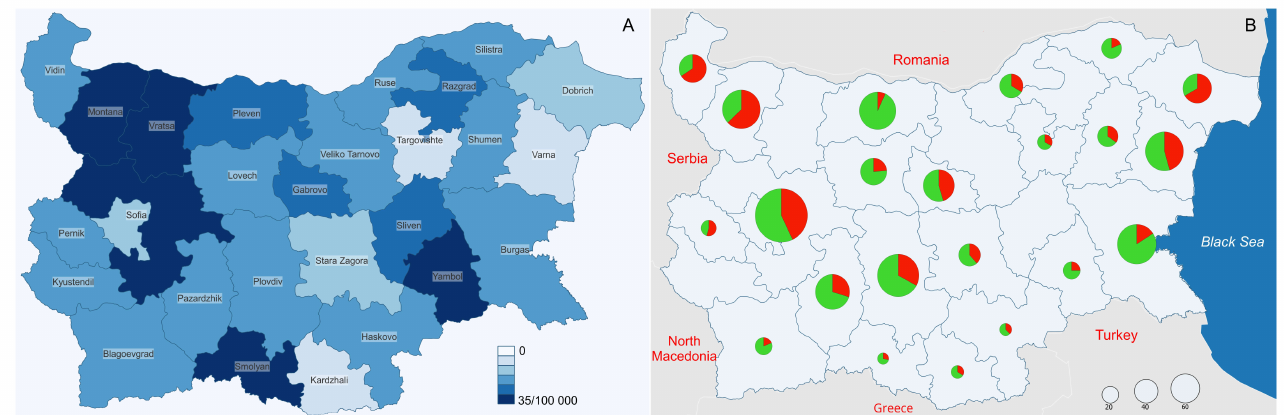
Figure 1. Map of Bulgaria with 28 administrative districts: ( A ) prevalence of new and relapse TB cases (2018); ( B ) sampling sites and proportion of drug sensitive (in green) and multidrug-resistant (in red) MTBC strains. Circle size corresponds to sample